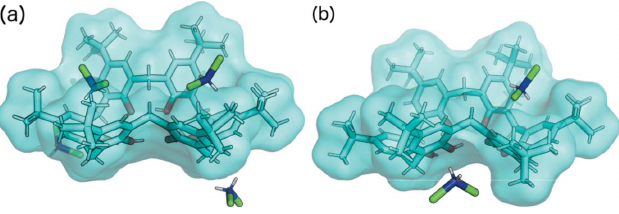
Figure 11 The asymmetric units of TBC6 solvated with DCM: ( a ) 1:4 ( 12 ) and ( b ) 1:2 ( 13 ). Disorder has been removed for